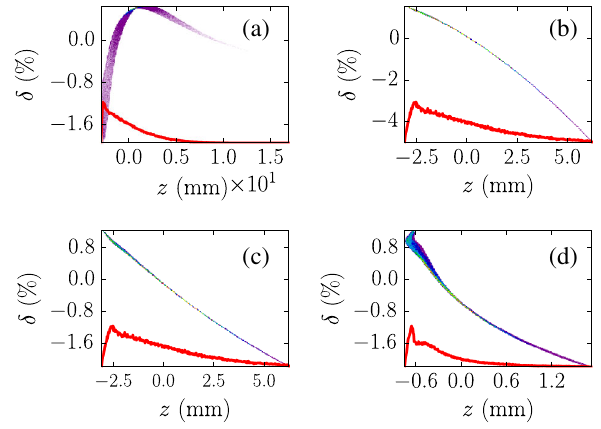
FIG. 10. Snapshots of the longitudinal phase spaces and associate current profiles (red traces) upstream of L0 (a) and downstream of L0 (b), L39 (c) and BC (d). Simulations up to L39 are carried with ASTRA whereas a one-dimensional longitudinal- dynamics model is used for BC2. The head of the bunch corresponds to z > 0